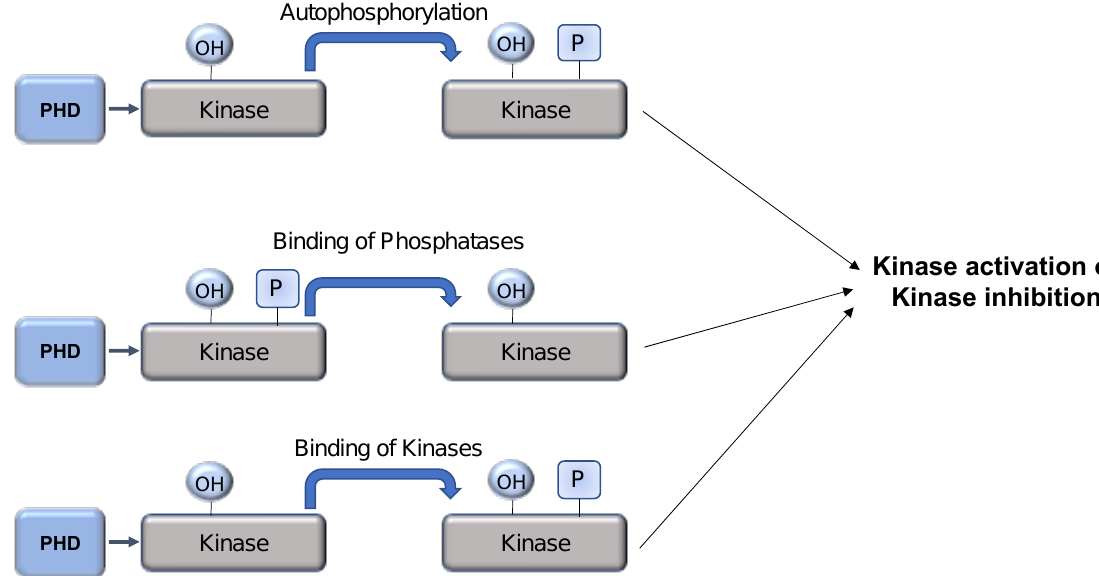
Figure 5. PHD-mediated hydroxylation as a mechanism to regulate kinase activity. Hydroxylation of kinases can lead to induction of autophosphorylation, recruitment of phosphatases, or even other kinases. This will result in changes to kinase activity.